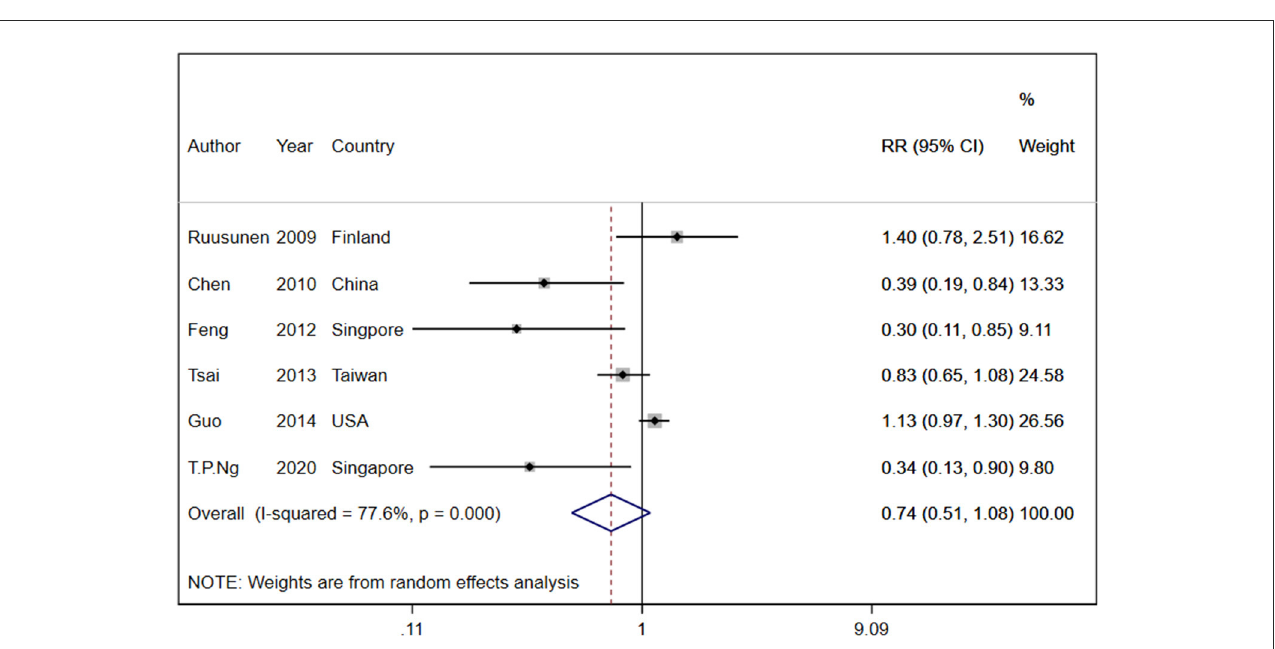
FIGURE3 Relative risk of depressive symptoms for the highest compared with the lowest category of tea intake. RR, relative risk.